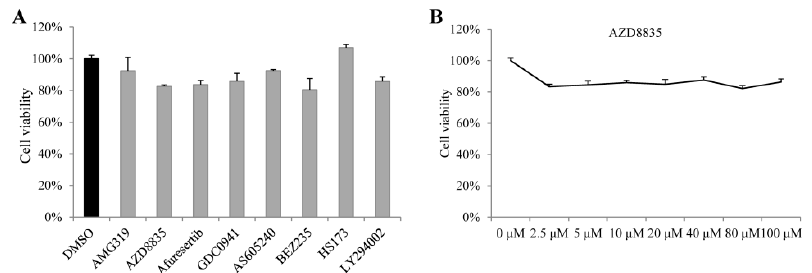
Figure 1. Cytotoxicity of candidate drugs. ( A ) BmE cells were incubated with 10 µM of each drug for 72 h. ( B ) BmE cells were incubated with different concentrations of AZD8835 for 72 h. The viability of cells was measured by the MTS assay. Bars, standard deviation.